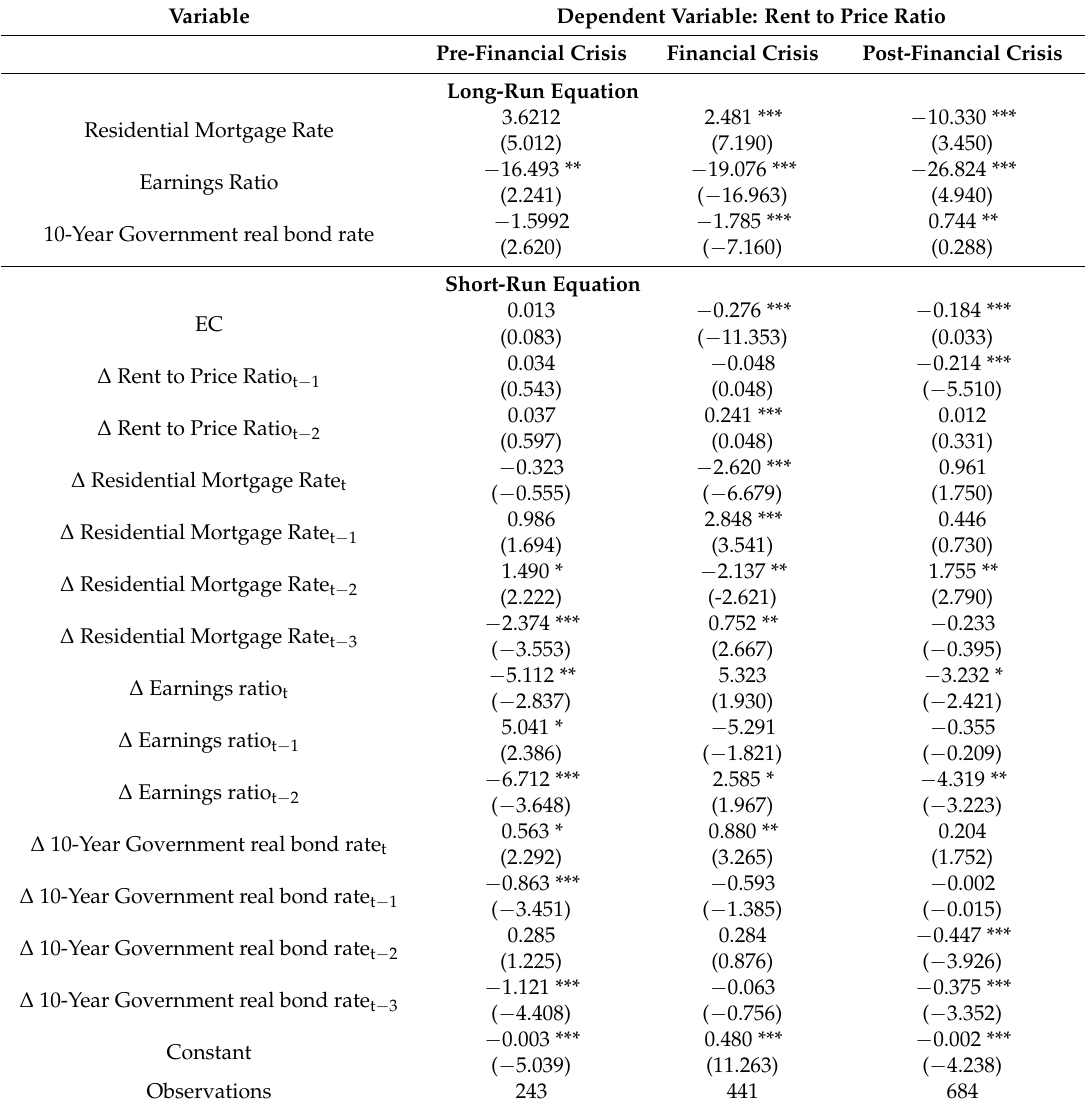
Table 6. Pooled mean group results during different time period based on Model